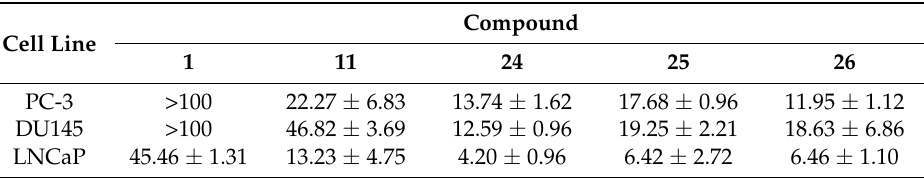
Table 3. Antiproliferative activities of derivatives 11 and 24 – 26 compared to quercetin in human prostate cancer cells 1,2